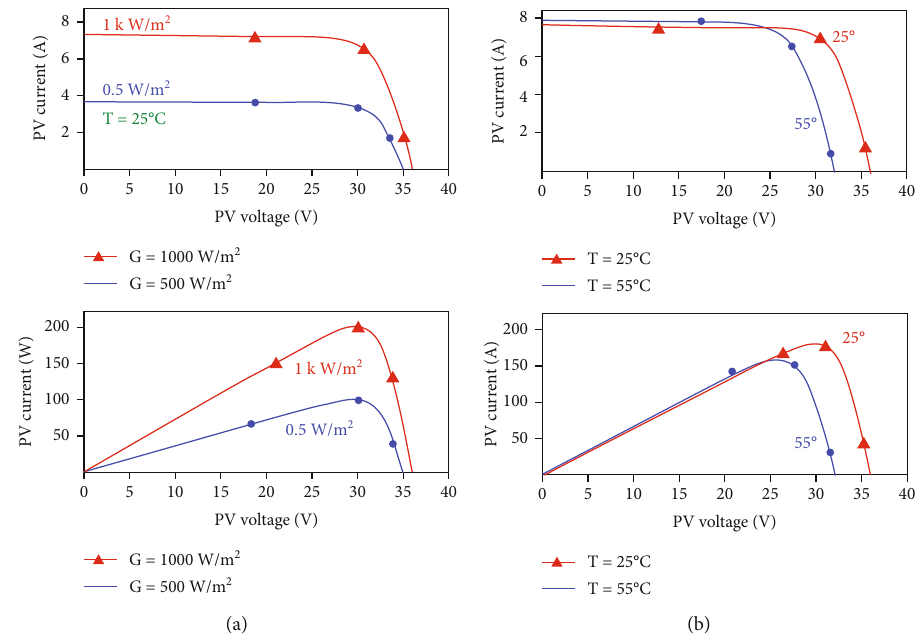
Figure 2: I-V and P-V characteristics of a PV panel. (a) Irradiance change. (b) Temperature change.